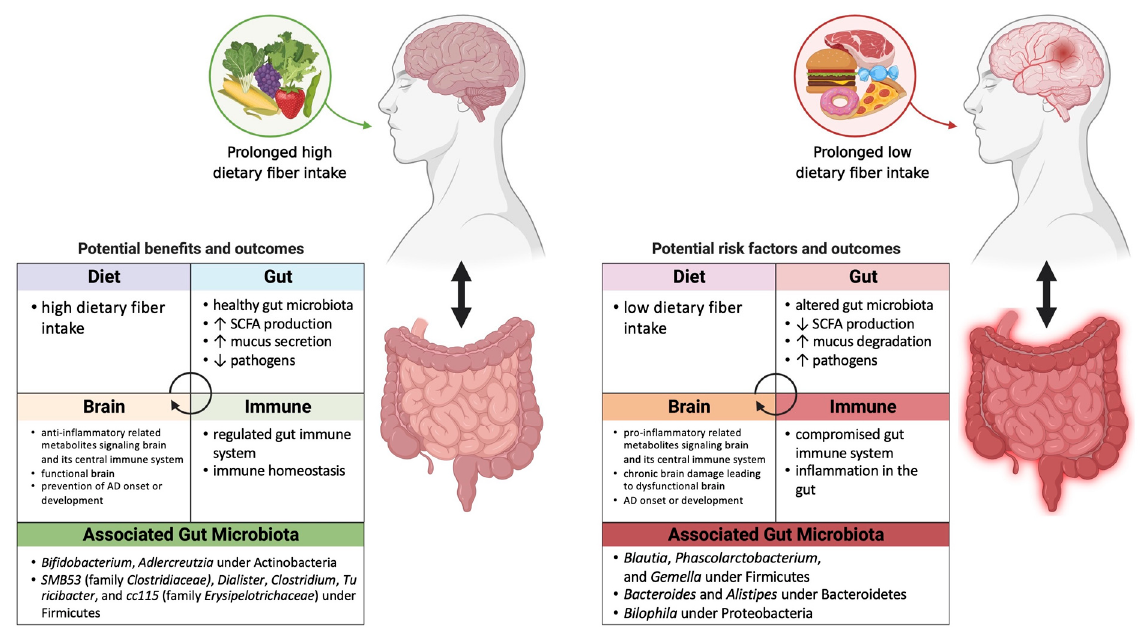
Figure 1. The potential association of prebiotic-gut-Alzheimer’s Disease (AD) in individuals with prolonged high vs. low fiber diet. The intake of dietary fiber may further influence gut health, immune system, and brain function. High dietary fiber intake may help maintain healthy gut microbiota, which is associated with increase in SCFA production, mucus secretion and decrease in pathogens. Healthy gut physiology leads to regulated gut immune system and immune homeostasis in which positively affects the brain. Anti-inflammatory metabolites signal the brain and its central immune system, which may potentially contribute to functional brain and prevention of AD onset or development. Bacterial genera that are shown to be less abundant in AD patients were Bifidobacterium and Adlercreutzia under Actinobacteria, SMB53 (family Clostridiaceae) , Dialister , Clostridium , Turicibacter , and cc115 (family Erysipelotrichaceae ) under Firmicutes. Low dietary fiber intake may alter gut microbiota leading to dysbiosis in the gut, decrease in SCFA production, and increase in pathogens. Dysbiosis in the gut may cause compromised gut immune system and inflammation in the gut. Pro-inflammatory metabolites signal the brain and its central immune system and potentially bring chronic damage to the brain, which may result in dysfunctional brain, AD onset or development. Bacterial genera that are shown to be more abundant in AD patients were Blautia , Phascolarctobacterium , and Gemella under Firmicutes, Bacteroides and Alistipes under Bacteroidetes, Bilophila under Proteobacteria.